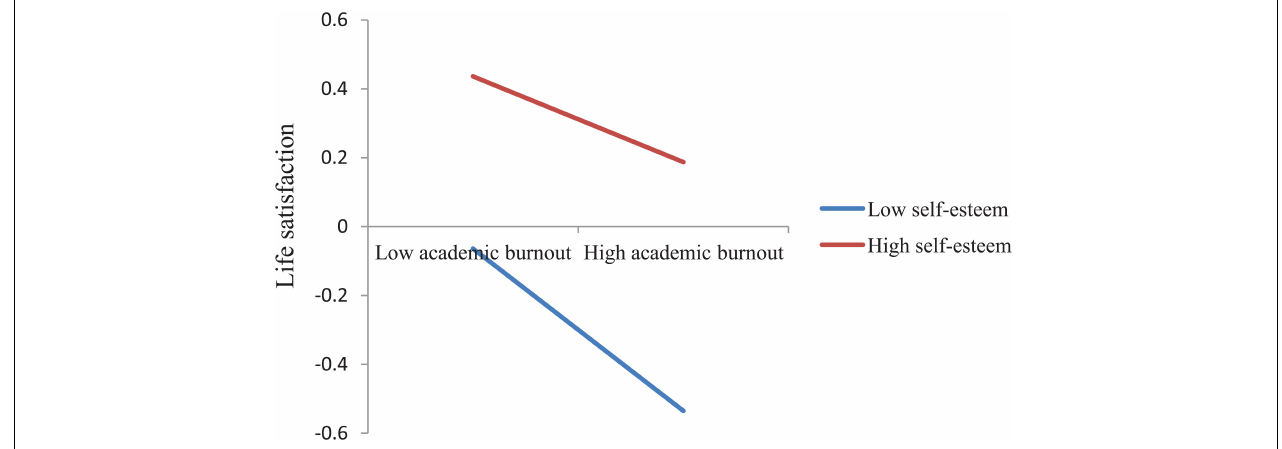
FIGURE 4 | The interaction effect of academic burnout and self-esteem on life